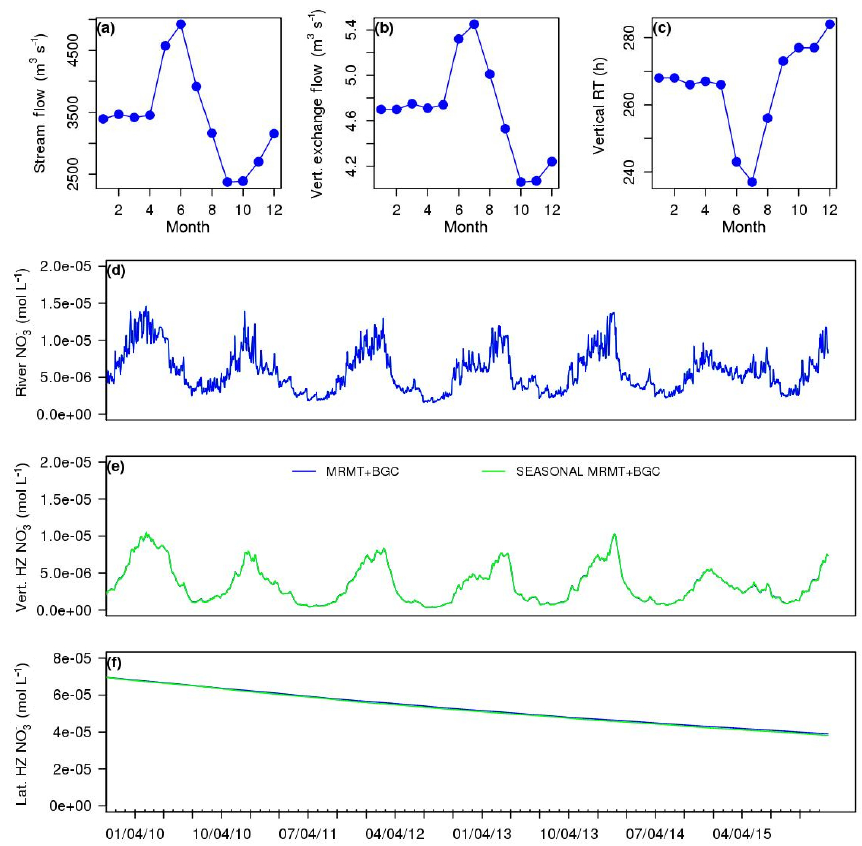
Figure 6. Effect of streamflow dynamics (a) on hyporheic exchange (b, c) and the nitrate concentration in the stream (d) , vertical HZ (e) , and lateral HZ (f) using exchange rates derived from annual discharge (blue line) and seasonal discharge (green line) at the outlet.